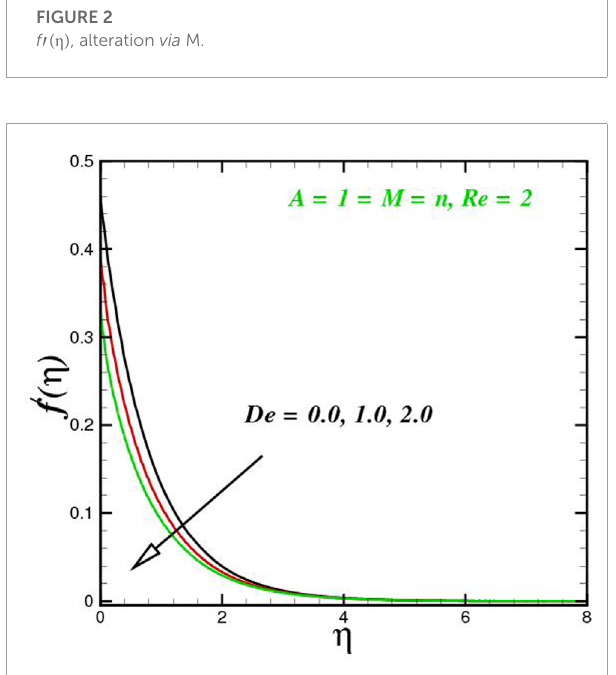
FIGURE 3 f ′( η ) , alteration via De.